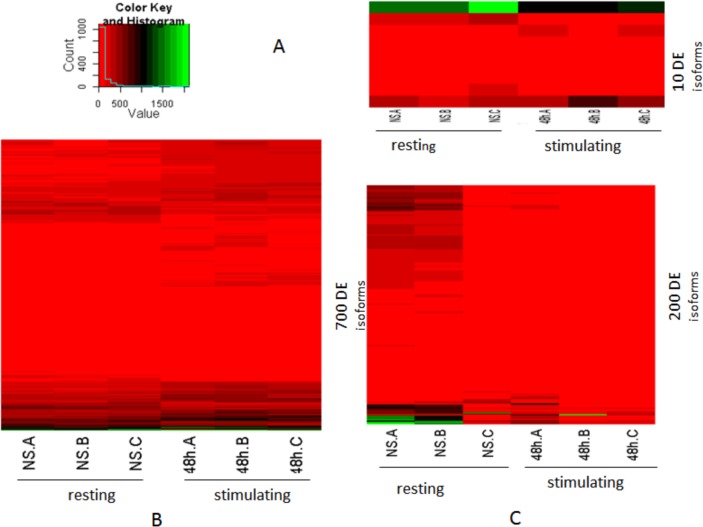
Heatmaps of Expressions of Transcripts Identified Only by Single Statistical Methods from Real Transcriptomic Datasets.
A: 10 Isoforms were specifically called differential expression by mBeta t-test. B: 700 isoforms were specifically found to be differentially expressed by Beta t-test. C: 220 DE isoforms were defined only by edgeR Exact test. NS: non-stimulated cells. 48h: stimulated cells via antigen receptor for 48 hours. A, B, and C are replicates.